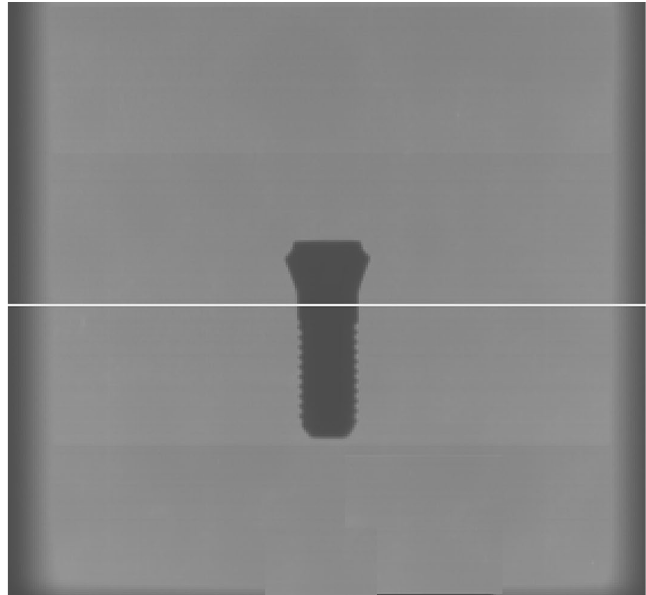
Figure 1. Exemplary 2D projection radiograph from the 3D Accuitomo with the Y-TZP-implant positioned in the center of the FOV. The white line represents the line along which the gray value profile was measured and evaluated, so that in eventually only the values within the implant image were used for computing